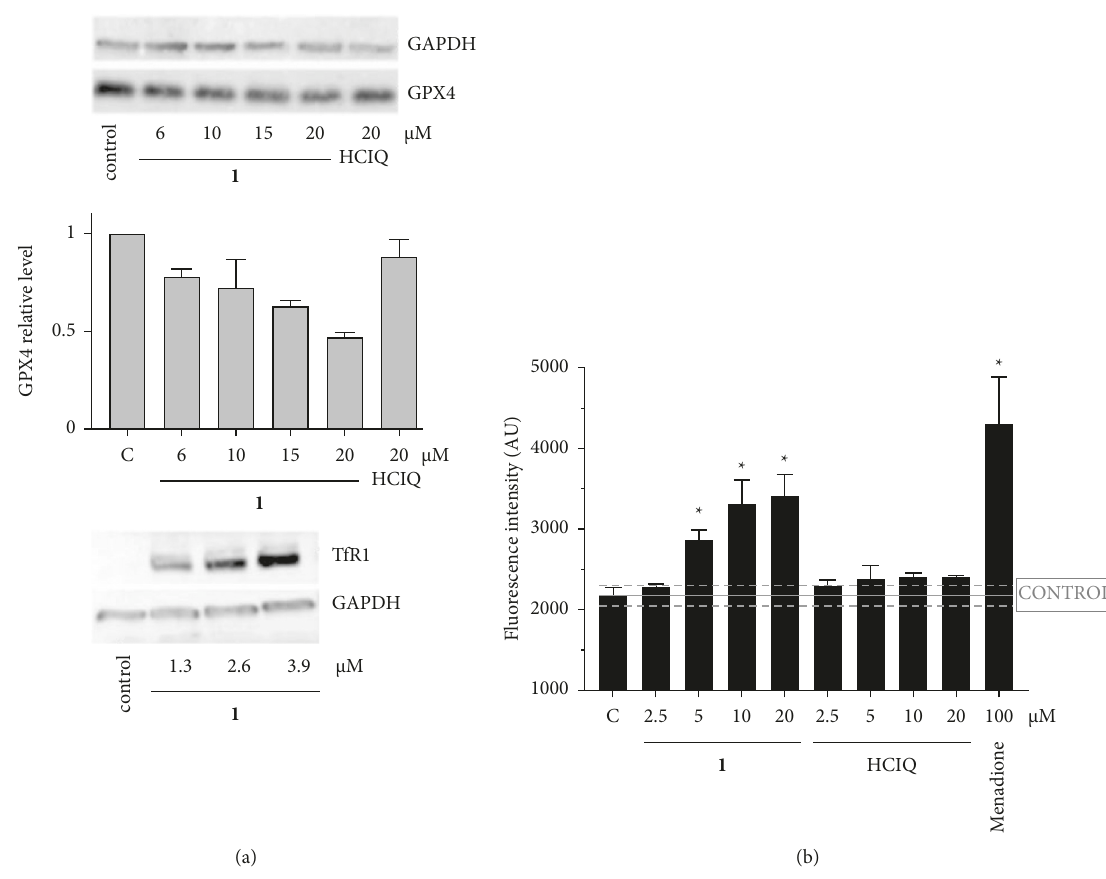
Figure 6: (a). Western-blot analysis of GPX4 and TfR1 levels. Representative membranes are shown. Middle panel: (a) Quantitative analysis of GPX4 level (relative to loading control GAPDH); the level of GPX4 in untreated cells is taken as 1. Bars represent a mean